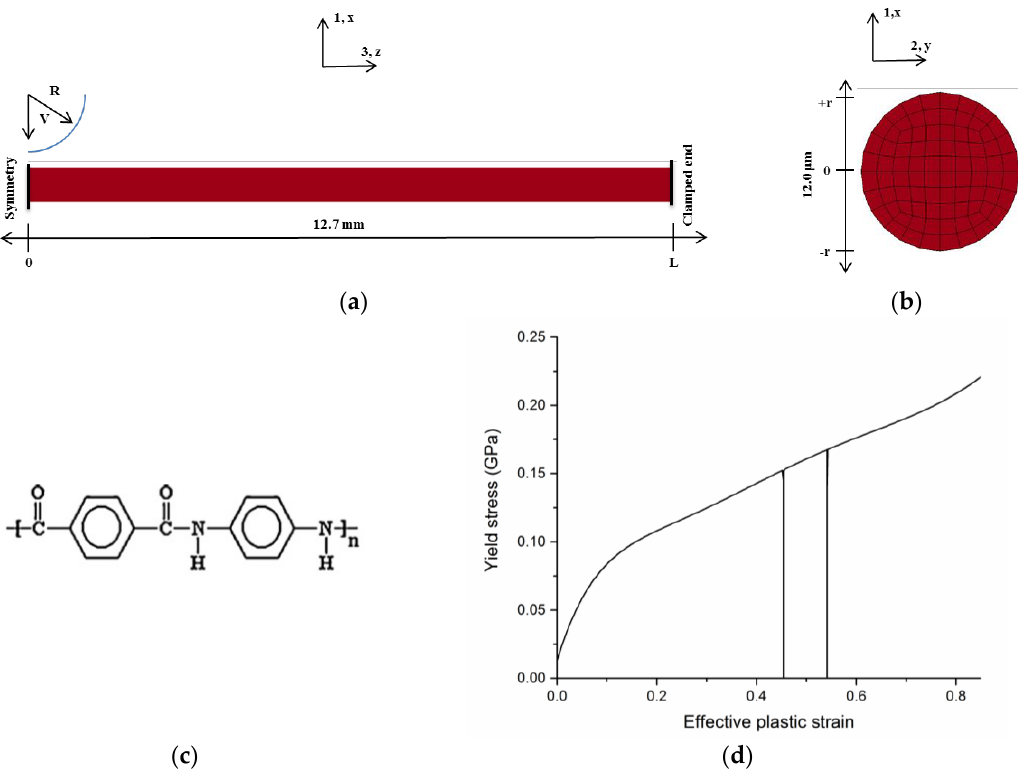
Figure 2. Half-symmetric 3D single-fiber model (not to scale); ( a ) cylindrical impact at the mid-span; ( b ) fiber cross-section; ( c ) structure of Kevlar; and ( d ) yield stress-effective plastic strain in transverse compression. Table 2. Transversely isotropic properties of a Kevlar KM2 single-fiber [21,22]. Table 1. Yarn breaking speed [5,6,19]. PBO: